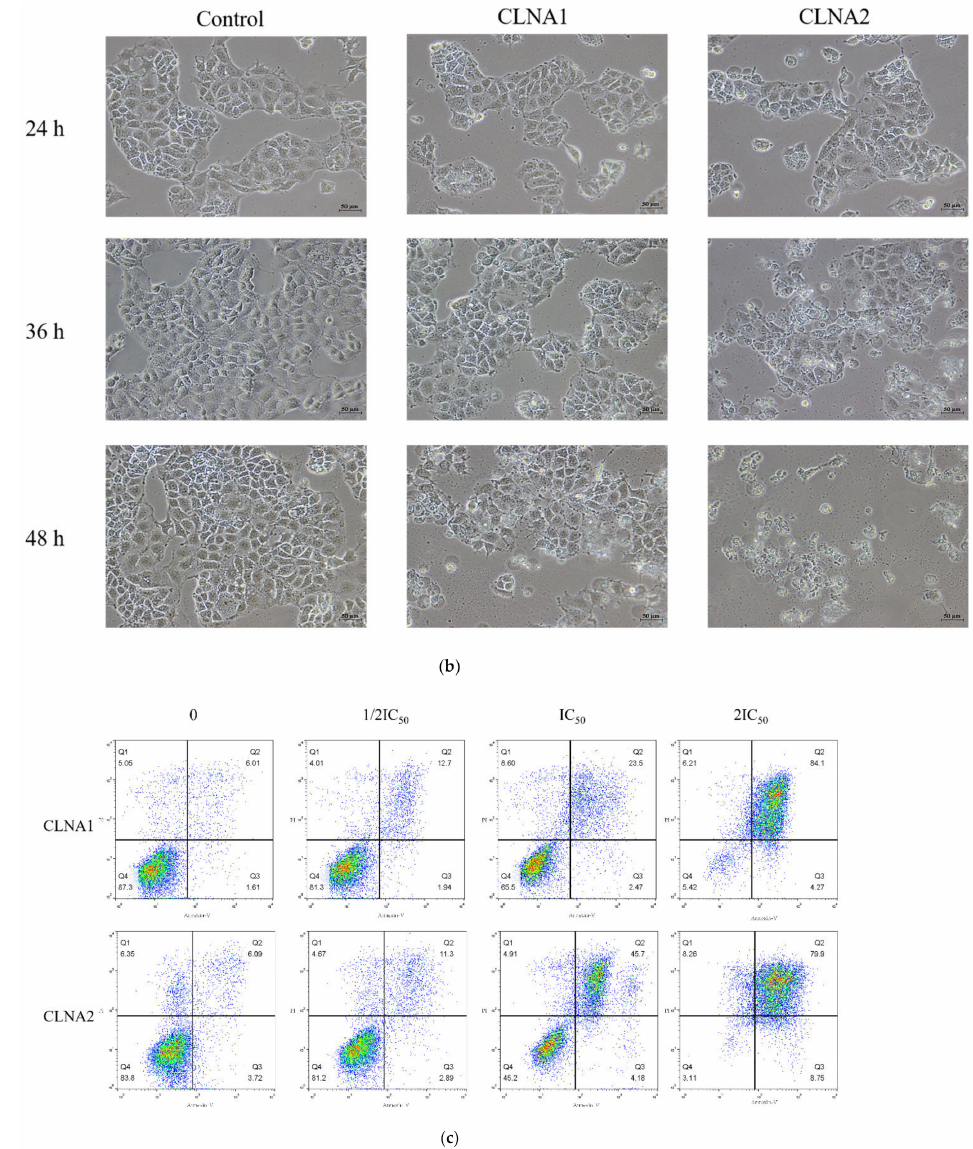
Figure 3. Anti-proliferative activity of CLNA1, CLNA2 against colon cancer cells. ( a ) Anti-proliferative e ff ects of ALA, CLNA1, CLNA2 on three kinds of colon cancer cell lines and the corresponding IC50. ( b ) Morphology and quantity of Caco-2 cells treated by CLNA1 and CLNA2 at di ff erent time points. And the scale bar of every picture is 50 µ m. ( c ) Flow cytometry of propidium iodide and annexin V-fluorescein isothiocyanate (FITC)-stained Caco-2 cells stimulated by di ff erent concentrations of CLNA1 or CLNA2 for 48 h. Data are presented as mean ± SEM and at least three separate experiments were performed in all studies. *, p < 0.05, **, p < 0.01 and ***, p < 0.001 compared with